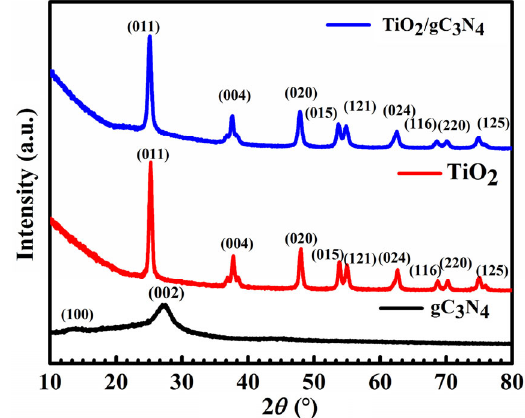
Fig. 1 Powder XRD pattern of gC 3 N 4 , TiO 2 , and TiO 2 /gC 3 N 4